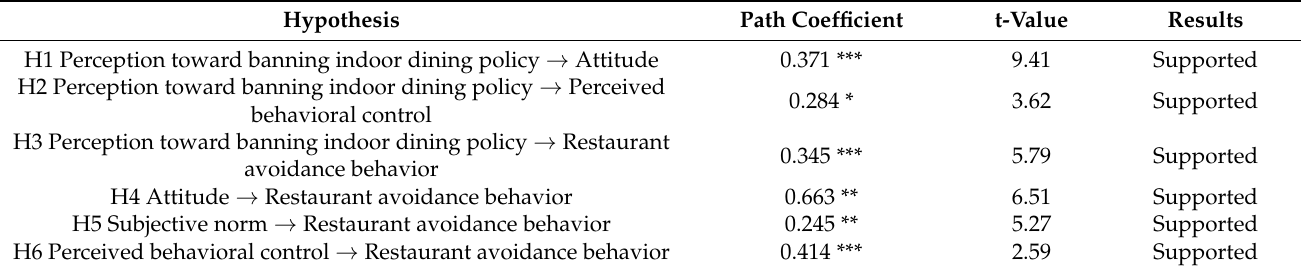
Table 4. Research hypothesis